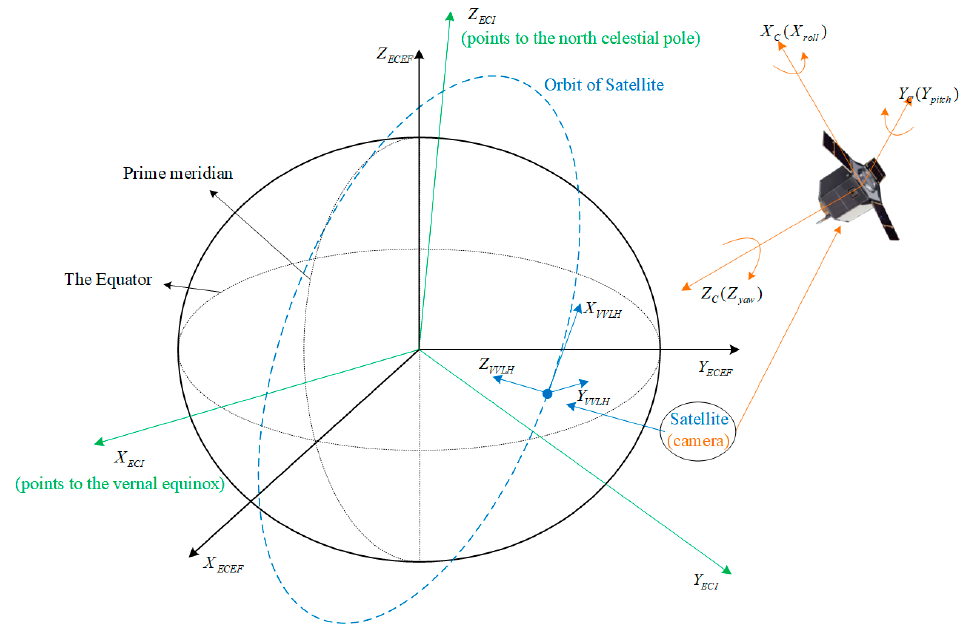
Figure 2. Coordinate system in satellite image geographic positioning.